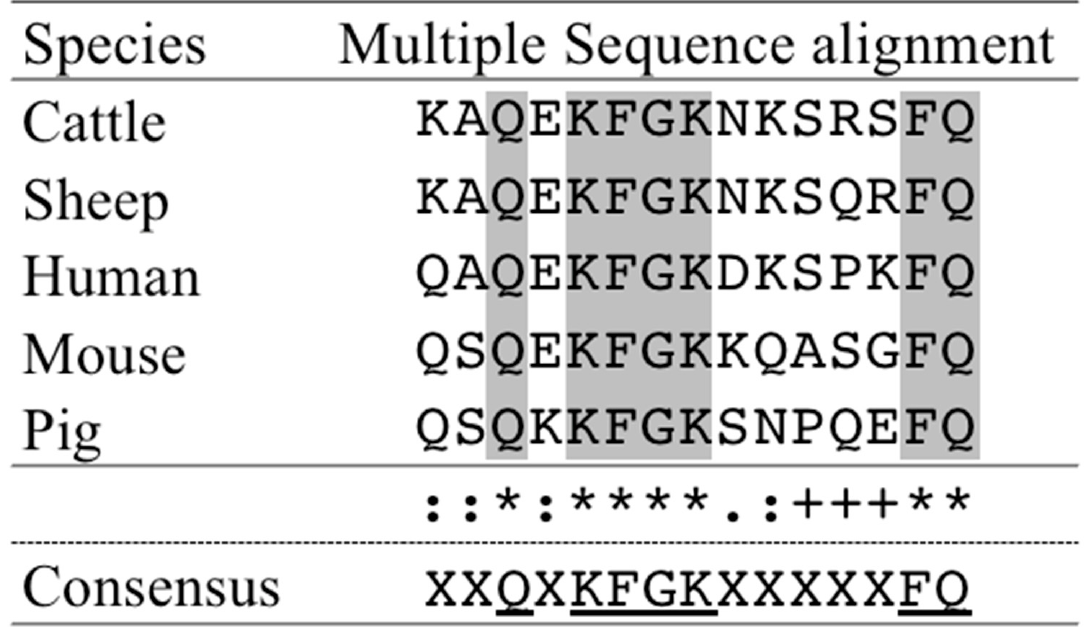
Figure 5. The sequence of cattle lactoferrin immunogen peptide was multiple aligned with the corresponding regions of the lactoferrin peptide from other species. The consensus amino acids are underlined and are highlighted in gray. (*) indicates fully conserved residue. (:) indicates conserved amino acid substitutions. (.) indicates semi-conserved substitution. (+) indicates no conservation.